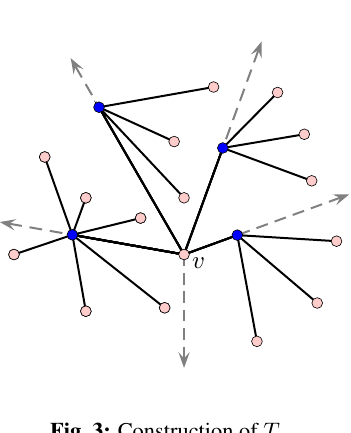
Fig. 3: Construction of T